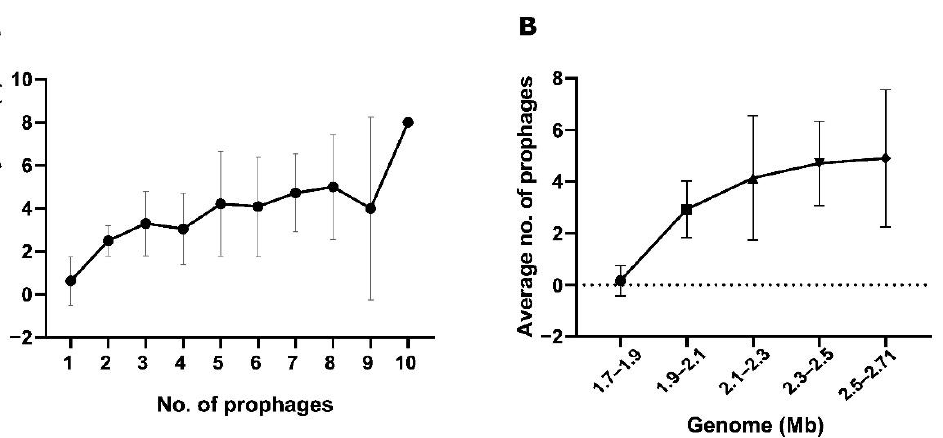
Figure 7. Association between number of prophages and defence systems or host genome size. ( A ) Average number of defence systems correlated with number of prophages identified in a genome (Spearman’s r = 0.40, p < 0.0001). ( B ) Average number of prophages per host genome size (Spearman’s r = 0.56, p < 0.0001).